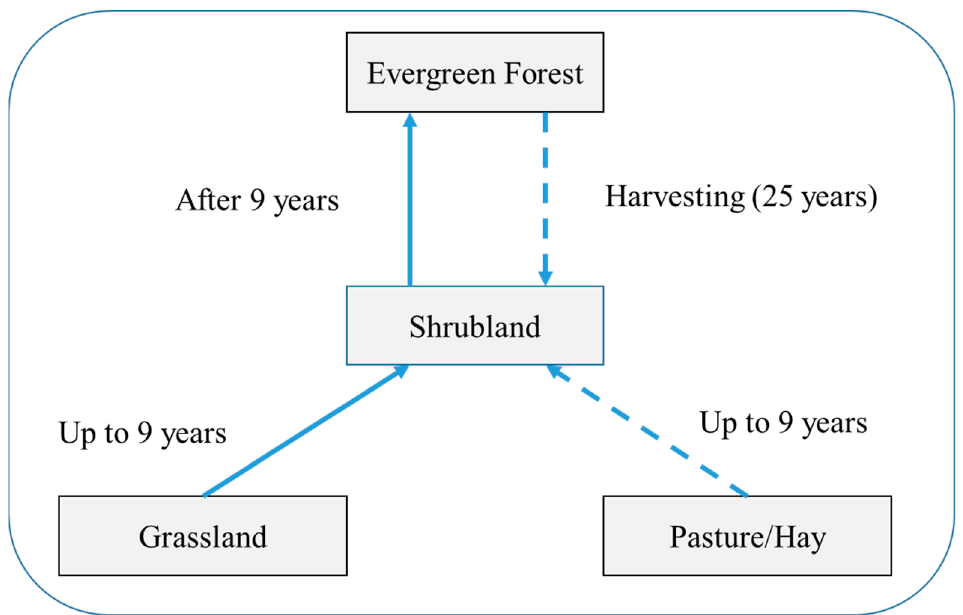
Figure 3. Transition rules between selected land covers in the watershed. A fixed number of pixels based on the transition rate from pasture/hay, grassland, and evergreen forest move to shrubland where they stay for the next nine years. After a nine-year period, they move to the evergreen forest where they stay until the harvest age of 25 years (a typical harvest age of loblolly pine in the southern United States) (source: Shrestha and Dwivedi [48]).